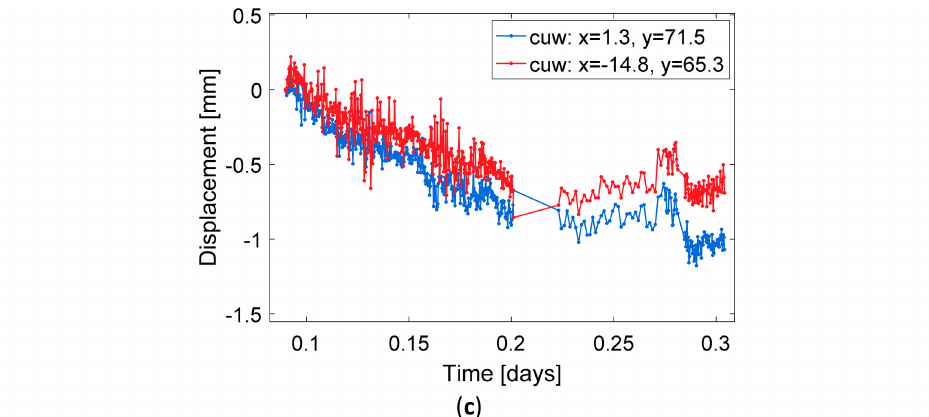
Figure 12. Displacement of sight line before atmospheric correction of the four representative PSs. ( a ) indicates points ( − 12.9, 69.8) and (4.9, 71.3); ( b ) is the box portion in ( a ), the corner reflector adjustment size has been marked in the figure, and ( c ) indicates the point (1.3, 71.5) with ( − 14.8, 65.3).